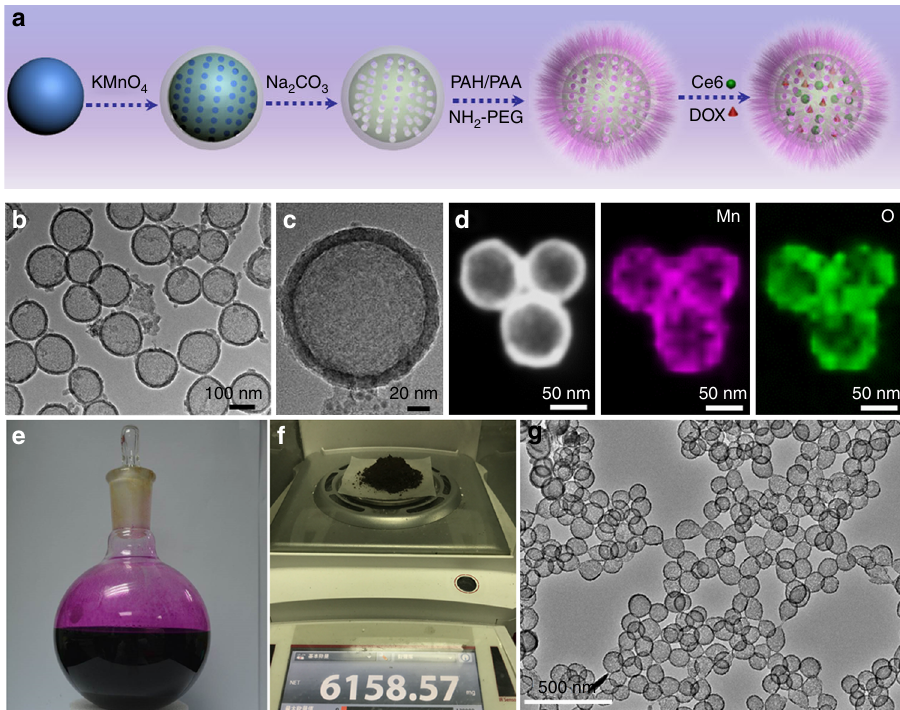
Fig. 1 Synthesis and characterization of H-MnO 2 -PEG. a A scheme indicating the step-by-step synthesis of H-MnO 2 -PEG nanoparticles and the subsequent dual-drug loading. b , c A TEM image ( b ) and a magni fi ed TEM image ( c ) of H-MnO 2 -PEG. d HAADF-STEM image and elemental mapping for H-MnO 2 - PEG. e A photo of the 500 mL reaction vessel for preparation of H-MnO 2 in a large scale. f Digital picture showing the gram-scale production of H-MnO 2 nanoshells in one reaction. g A representative TEM image of H-MnO 2 nanoshells prepared in the